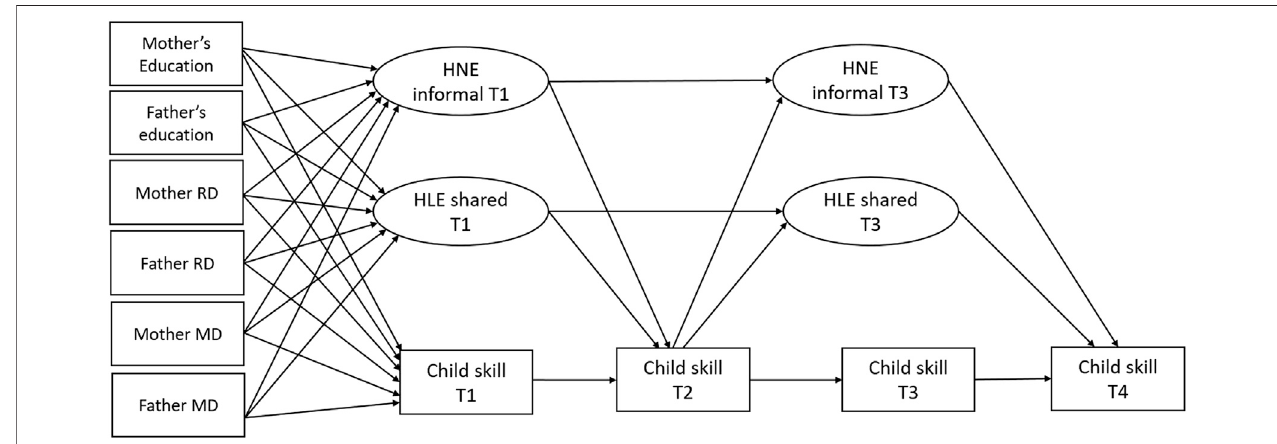
FIGURE 3 | The base-model for each numeracy and language skill with direct and indirect paths. Note: In addition to the regression paths depicted, the models included residual correlations between the variables in T1 and T3. In addition, speci fi c paths from parental skills to children ’ s skills were added for each individual skill model based on the step 1 models ( Figures 1 , 2 , and Tables 3 , 4